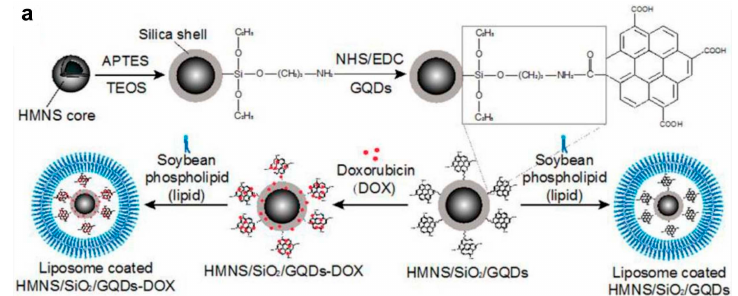
Figure 9. Cont. Figure 9.